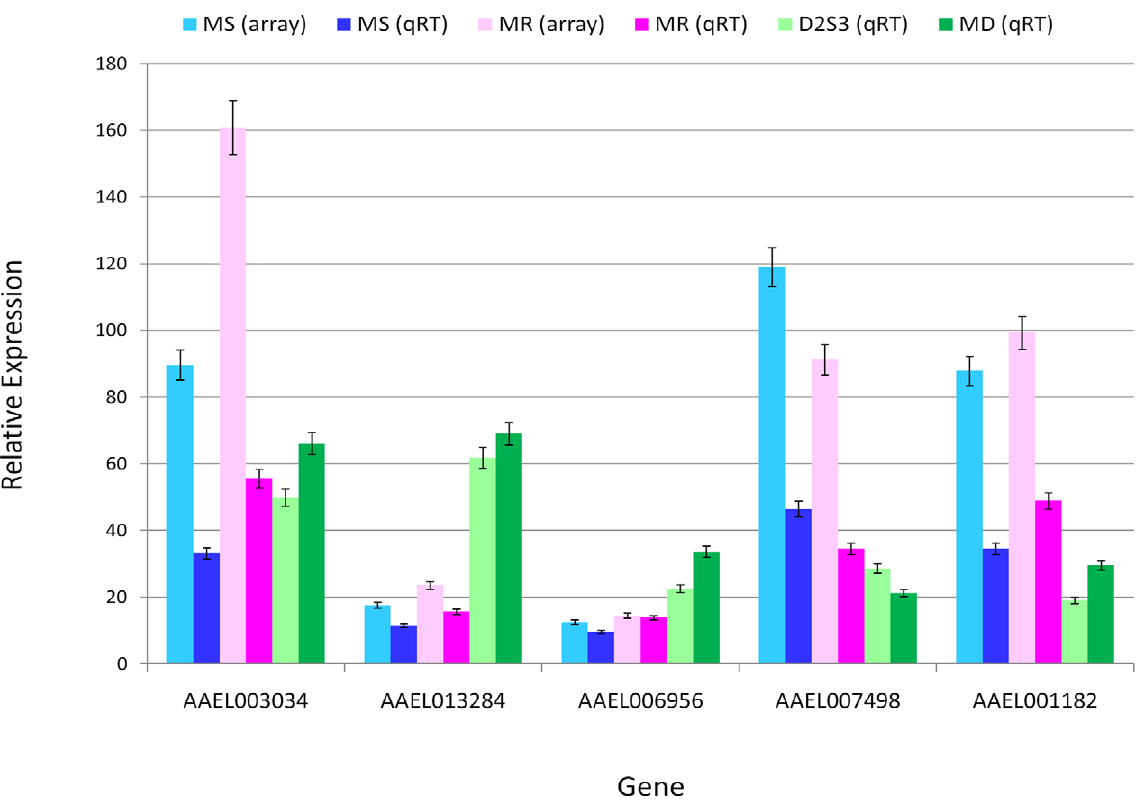
Figure 6. Validation of microarray expression of five genes by quantitative real-time PCR (qRT-PCR). For each gene, comparisons are made between array data (MS and MR strains) and the qRT-PCR data (MS and MR strains). Also, two additional strains of A. aegypti , D2S3 and MD, were infected with dengue (see text) and then compared for expression of the same genes by qRT-PCR. The relative gene expression (in comparison to the control) is shown in the Y-axis along with standard errors. The X-axis shows the gene identity.